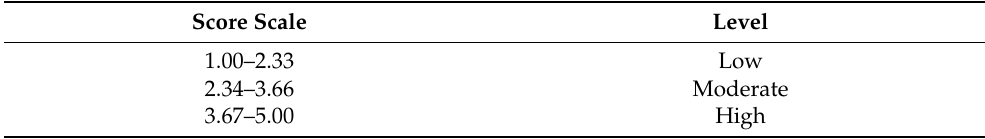
Table 5. Cutoff Point Level of Use of Learning Media.